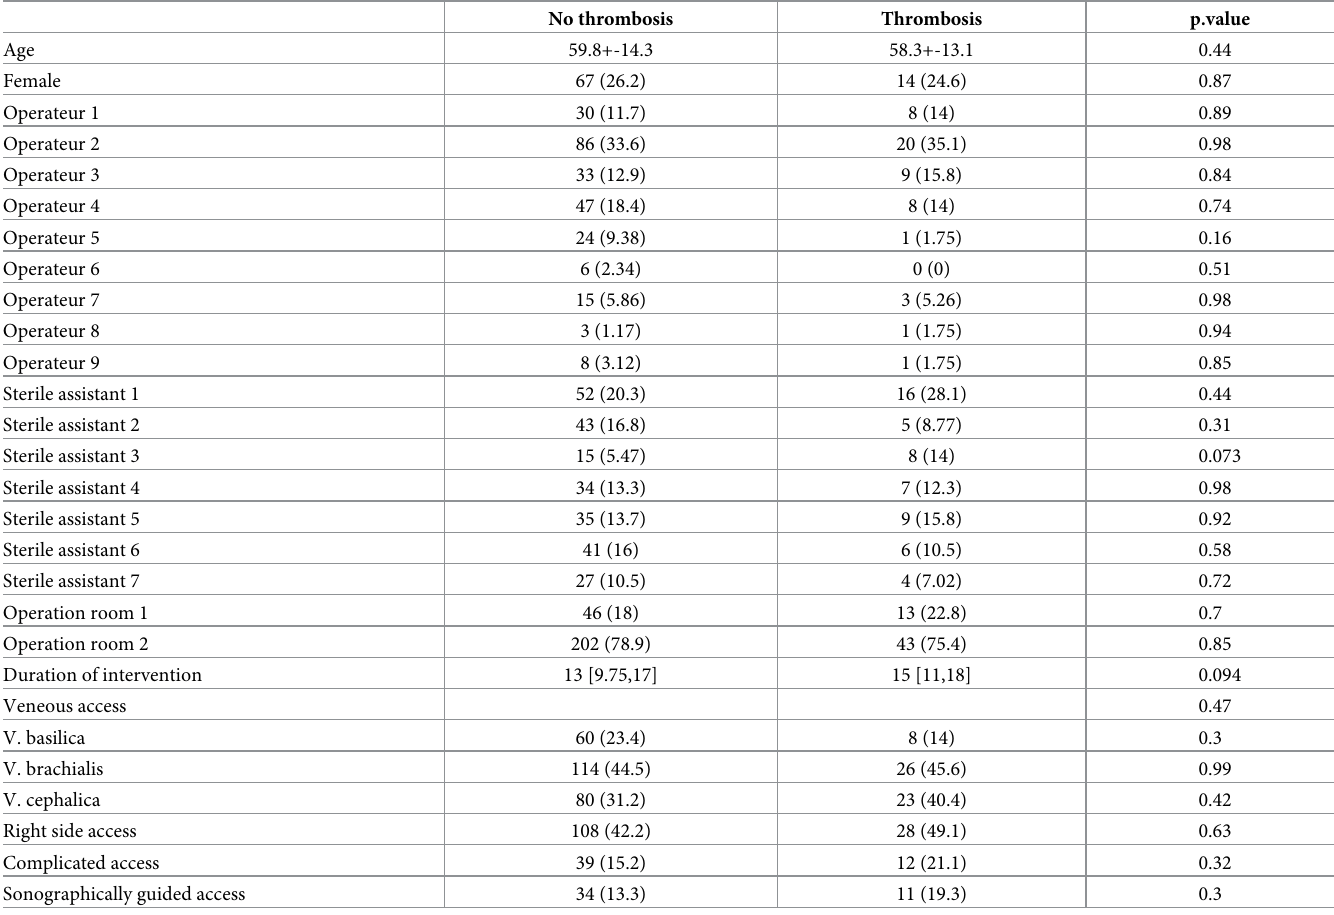
Table 2. Subgroup of patients with thrombosis after port implantation at the forearm with the subgroup of patients without thrombosis after